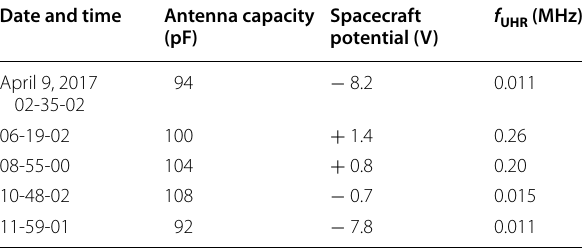
Table 4 Initial antenna capacity evaluation